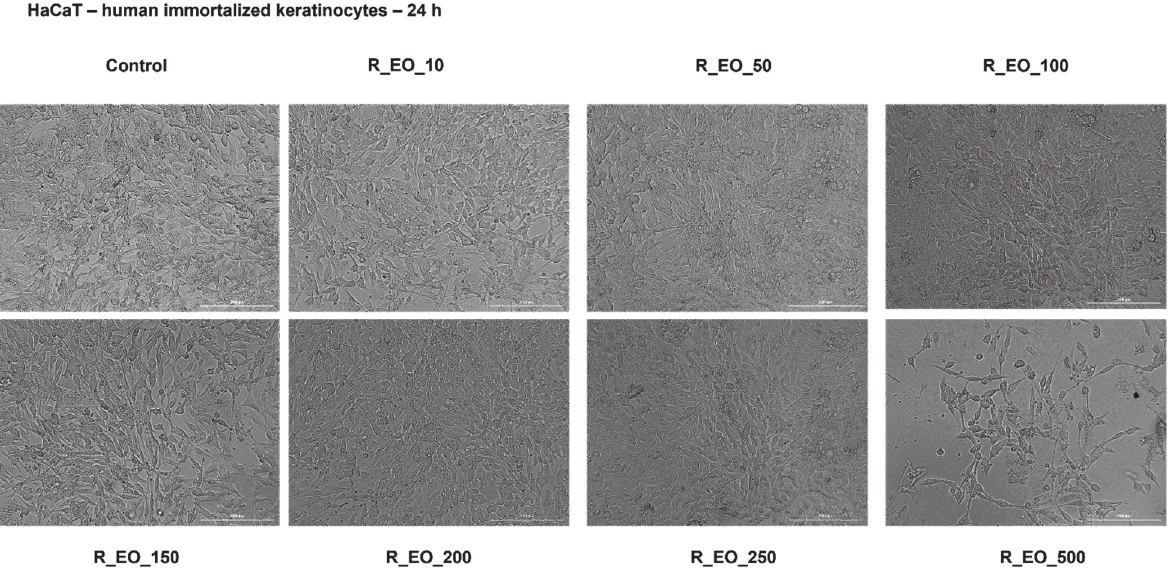
Figure 10. Morphological aspect of HaCaT cells after treatment for 24 h with Rosmarinus officinalis L. essential oil—R_EO (10, 50, 100, 150, 200, 250 and 500 μ g/mL). The scale bar was 200 μ m.